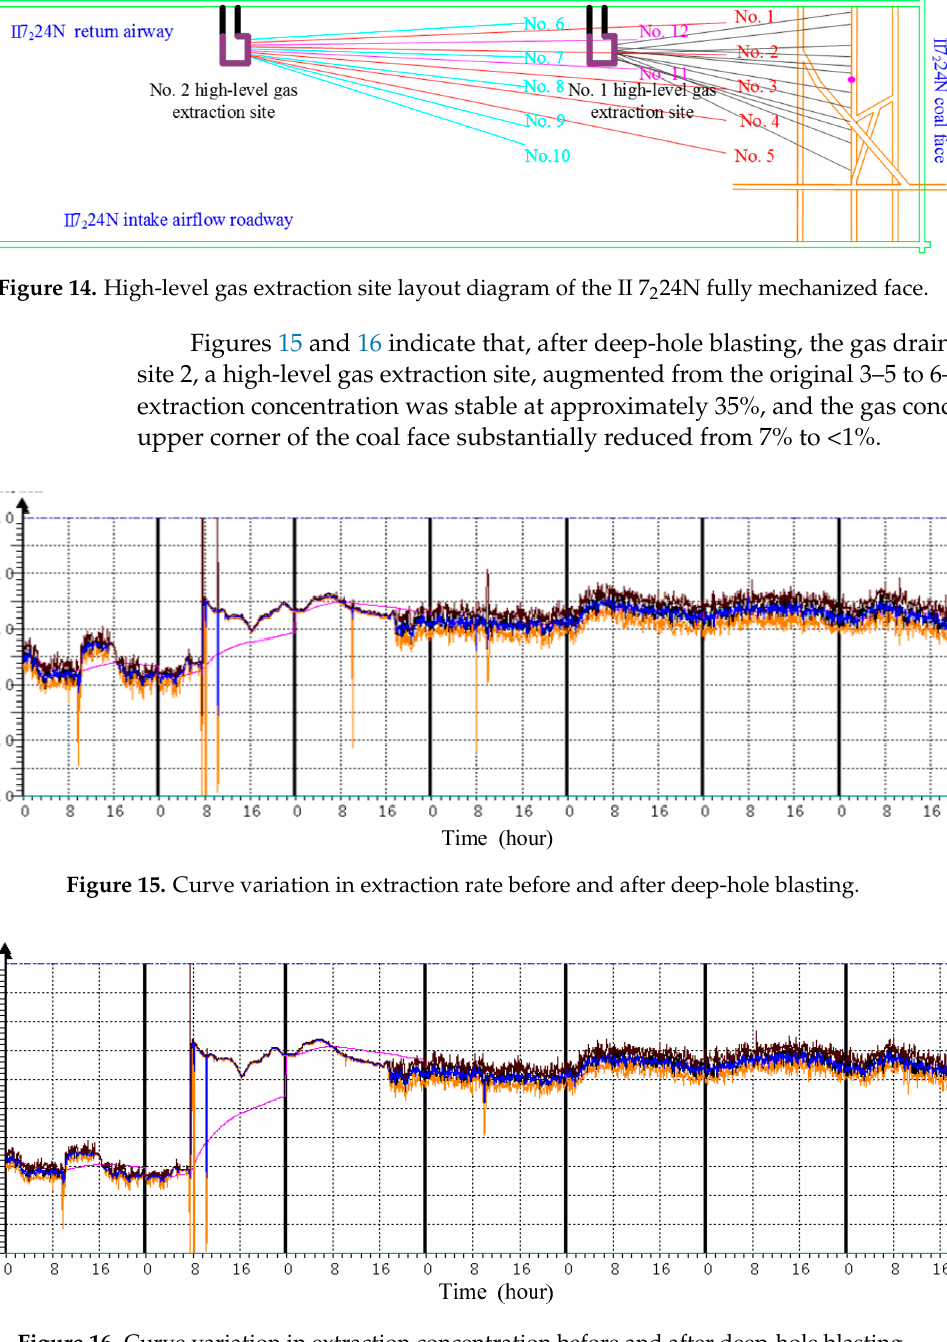
Figure 16. Curve variation in extraction concentration before and after deep-hole blasting.